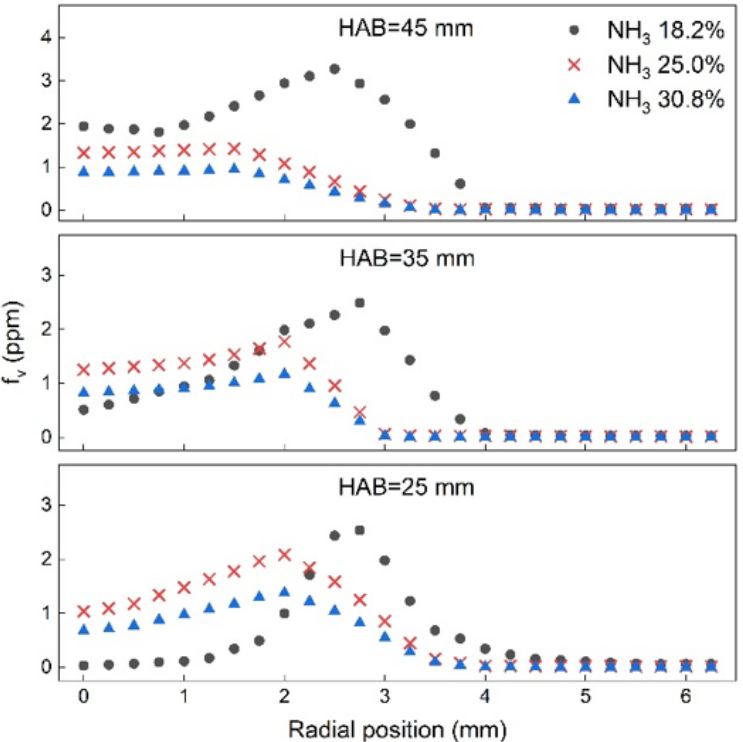
Figure 6. Half ‐ plane radial distribution of SVF for ethylene flames blended with NH 3 of different volume at HAB = 25, 35, and 45 mm. The C 2 H 4 was supplied at constant flow rate of 0.18 LPM. The normalized SVF of C 2 H 4 ‐ NH 3 flames and neat C 2 H 4 diffusion flame at the axial centerline are shown in Figure 7a. Being a sooty flame, the C 2 H 4 flame produces the largest amount of soot, followed by the increasing blend fraction of NH 3 . A non-monotonic decrease of soot production is reflected, where the 9.1% NH 3 blend shows a decrease by more than 50% compared to the neat C 2 H 4 flame, whereas the 16.7% NH 3 blend shows a